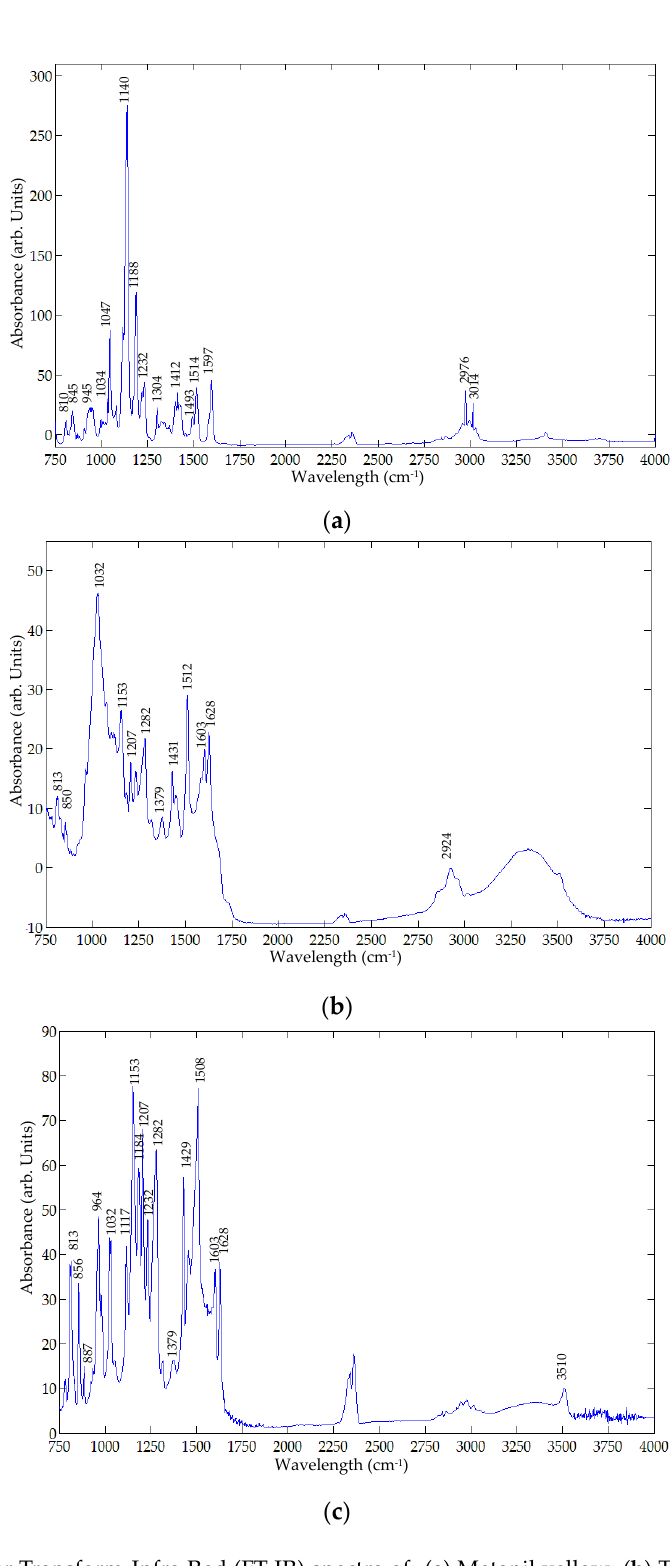
Figure 2. FT-Raman spectra of: ( a ) Metanil yellow; ( b ) Turmeric powder; ( c ) Curcumin.